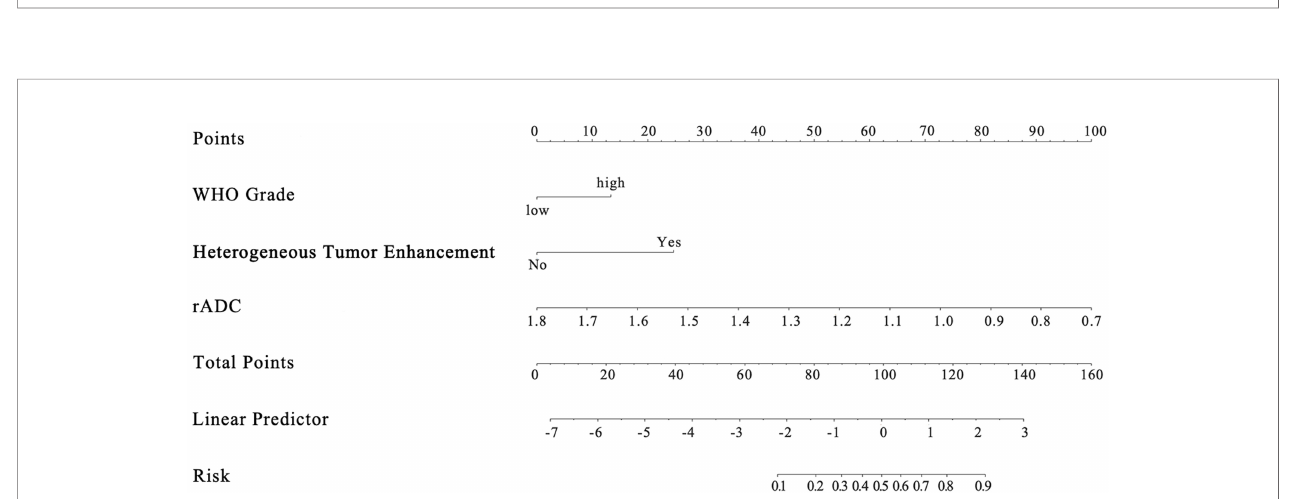
FIGURE 2 | Lasso regression for predicting postoperative recurrence of meningioma. (A) The number of independent variables of the model with good performance was 3; (B) The three variables were WHO grade, heterogeneous tumor enhancement and rADC value, respectively.